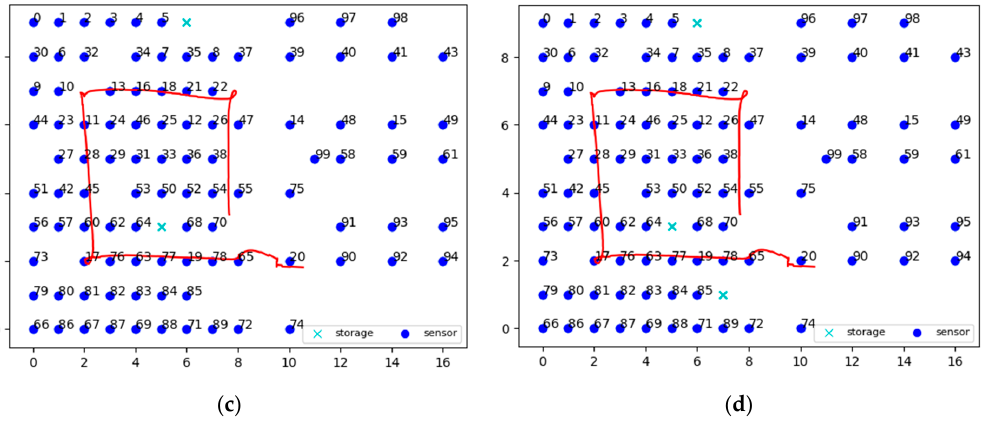
Figure 13. Trajectories over the topology of 100 nodes for ( a ) 3 servers, h_line_2 trajectory, r d = 4.5 ans α = 2.6, ( b ) 4 servers, h_line_2 trajectory, r d = 4.5 ans α = 2.6, ( c ) 2 servers, square_1_plus trajectory, r d = 3 ans α = 0, ( d ) 3 servers, square_1_plus trajectory, r d = 3 ans α = 0.